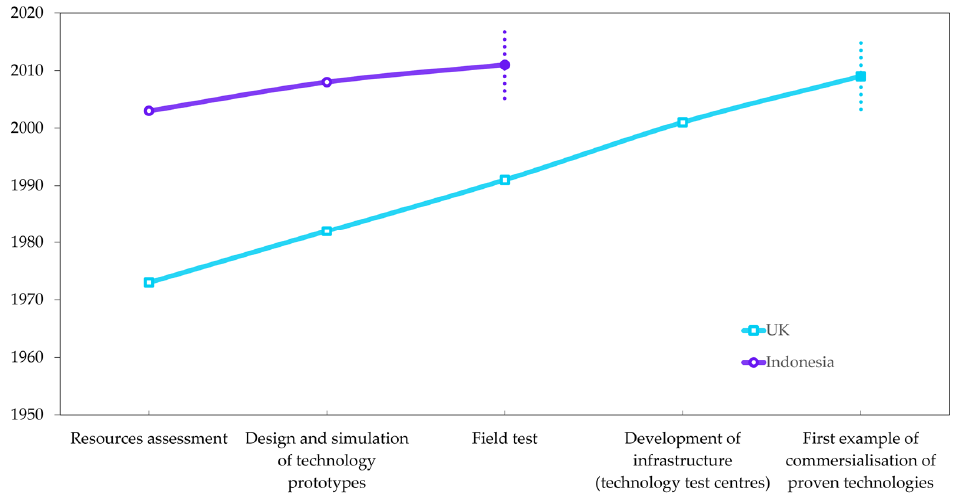
Figure 4. The development stage of MRE industry in the UK and Indonesia. (Solid circle and square with dotted lines indicate that the development stage in both countries until today).